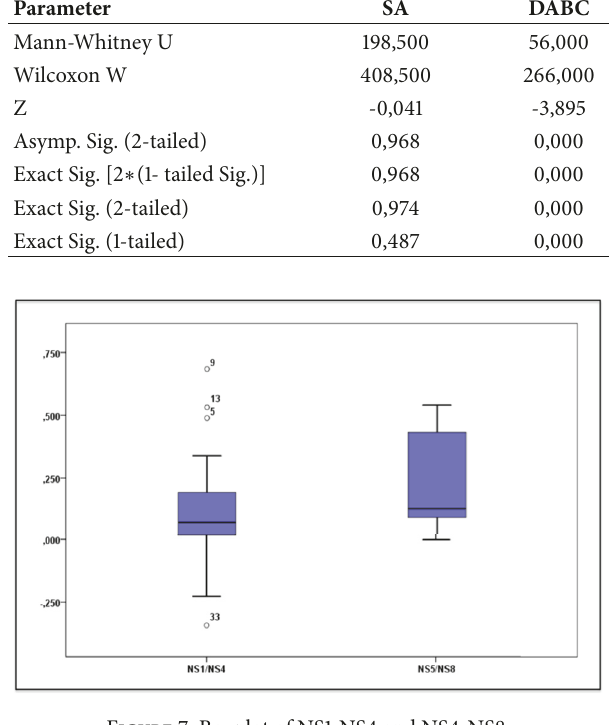
Figure 7: Boxplot of NS1-NS4 and